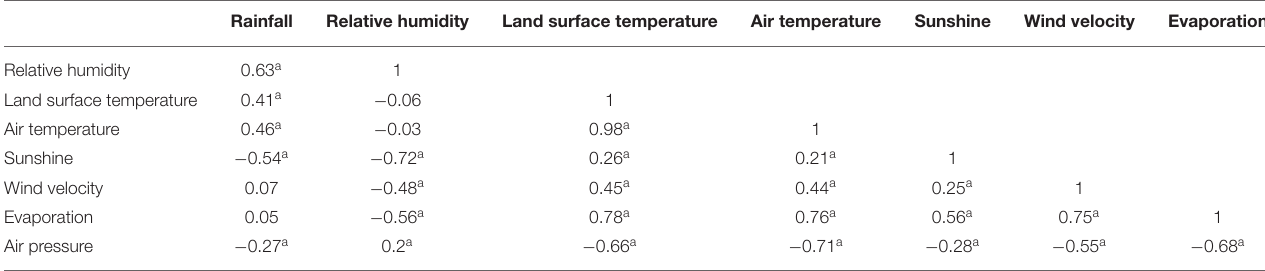
TABLE 2 | Spearman correlation coefficients between weekly meteorological variables in rural areas of Panzhihua district, Southwest China, 2008–2017. Rainfall